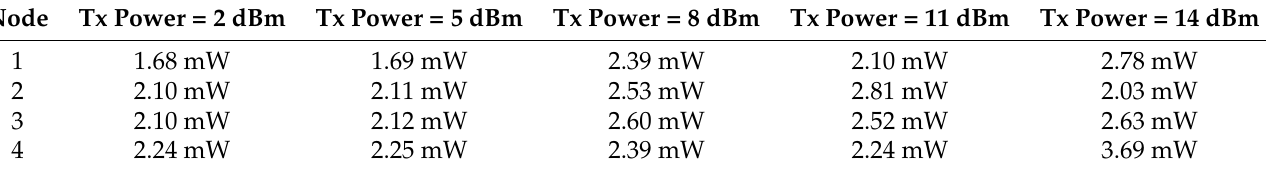
Figure 7. Energy consumption of nodes ( a – d ). Table 5. Energy consumption of nodes ‘2’.